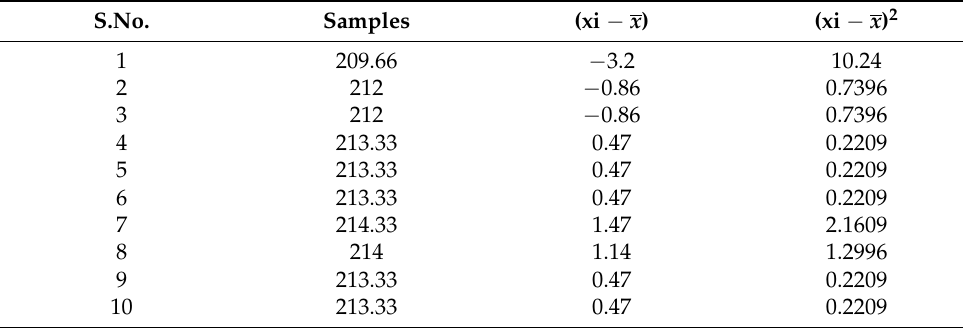
Table 3. t -test calculation on the samples collected in February 2020.